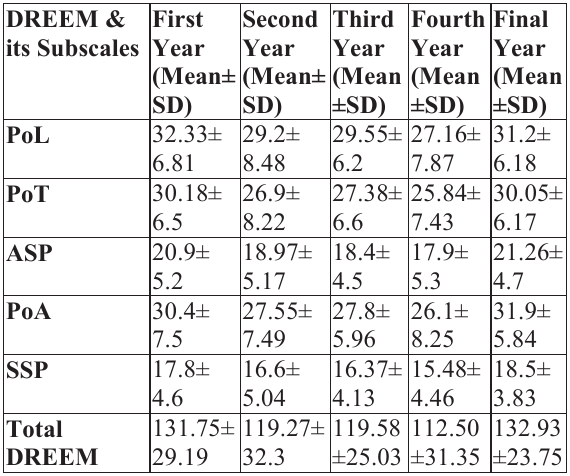
Table-2: Year wise mean scores of Total DREEM & its Subscales.